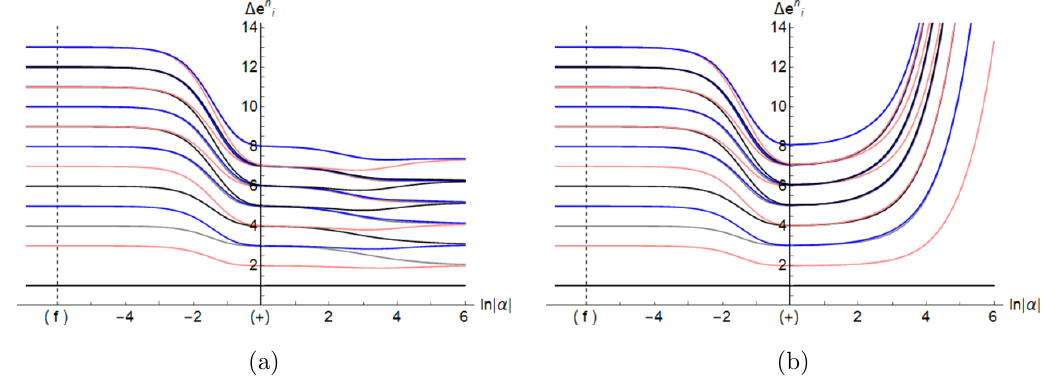
Figure 19. (a) NS Sector. TCSA normalised energy gaps with (cid:1) max = 31 : 5 against ln j (cid:11) j ; (b) NS Sector. TCSA normalised energy gaps with (cid:1) max = 32 against ln j (cid:11) j .